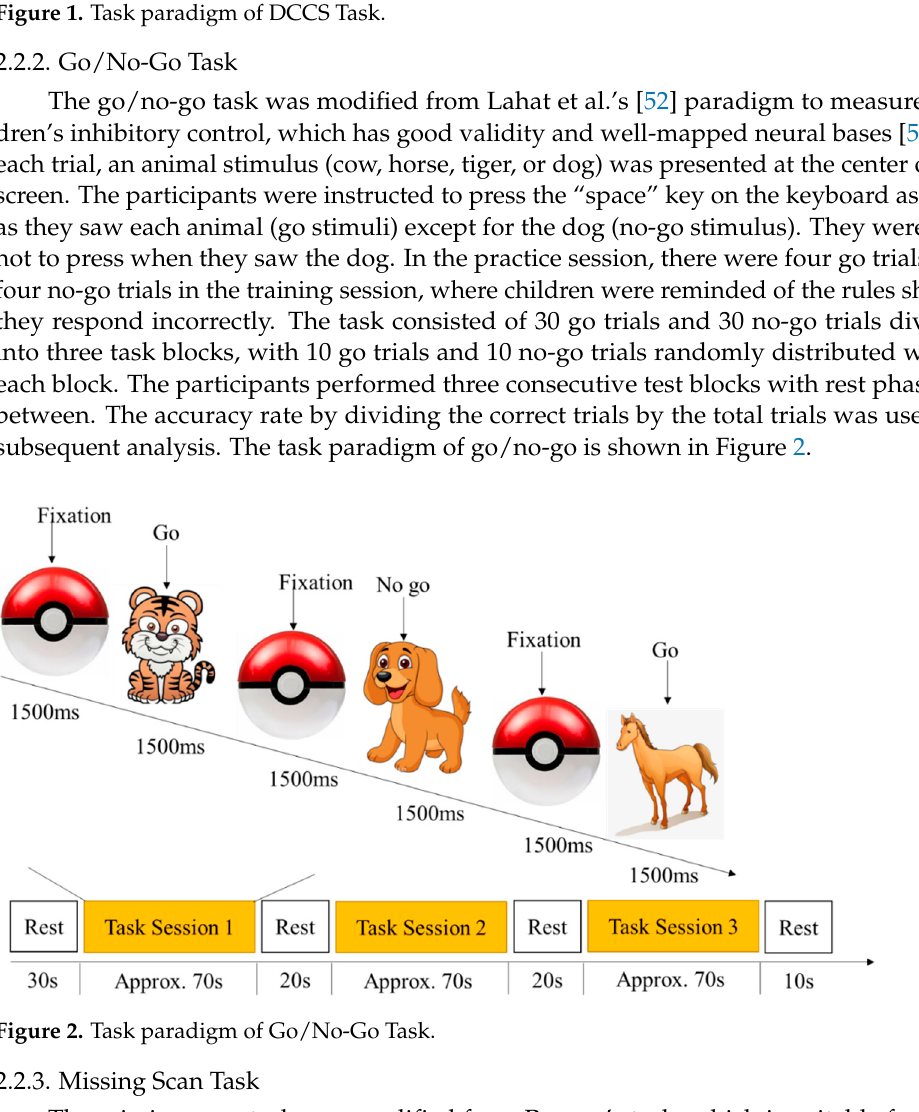
Figure 1. Task paradigm of DCCS Task.